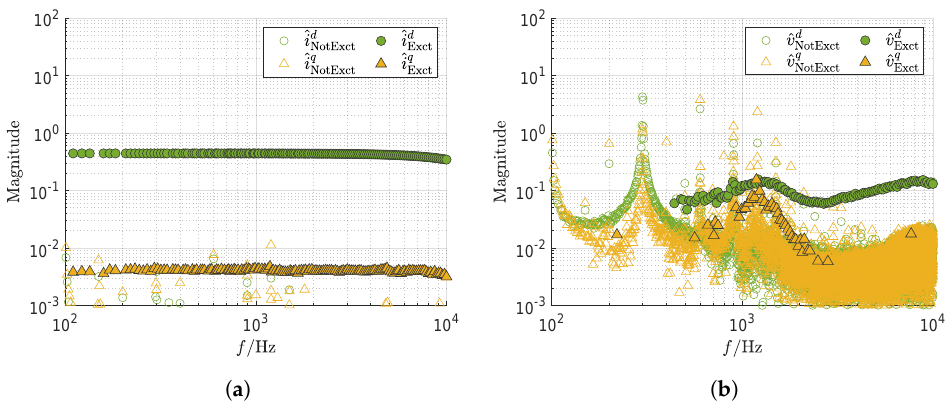
Figure 25. Compensated measurement of the industrial power grid during excitation of the d -axis. ( a ) Spectrum of the current i meas in the dq domain. ( b ) Spectrum of the voltage v meas in the dq domain. The compensation of the measurement was performed with the parameters in Table 4.